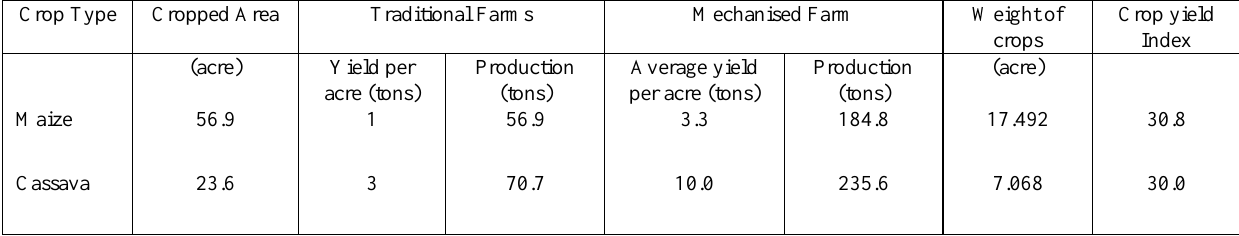
Table 2. Crop yield index and productivity levels for maize and